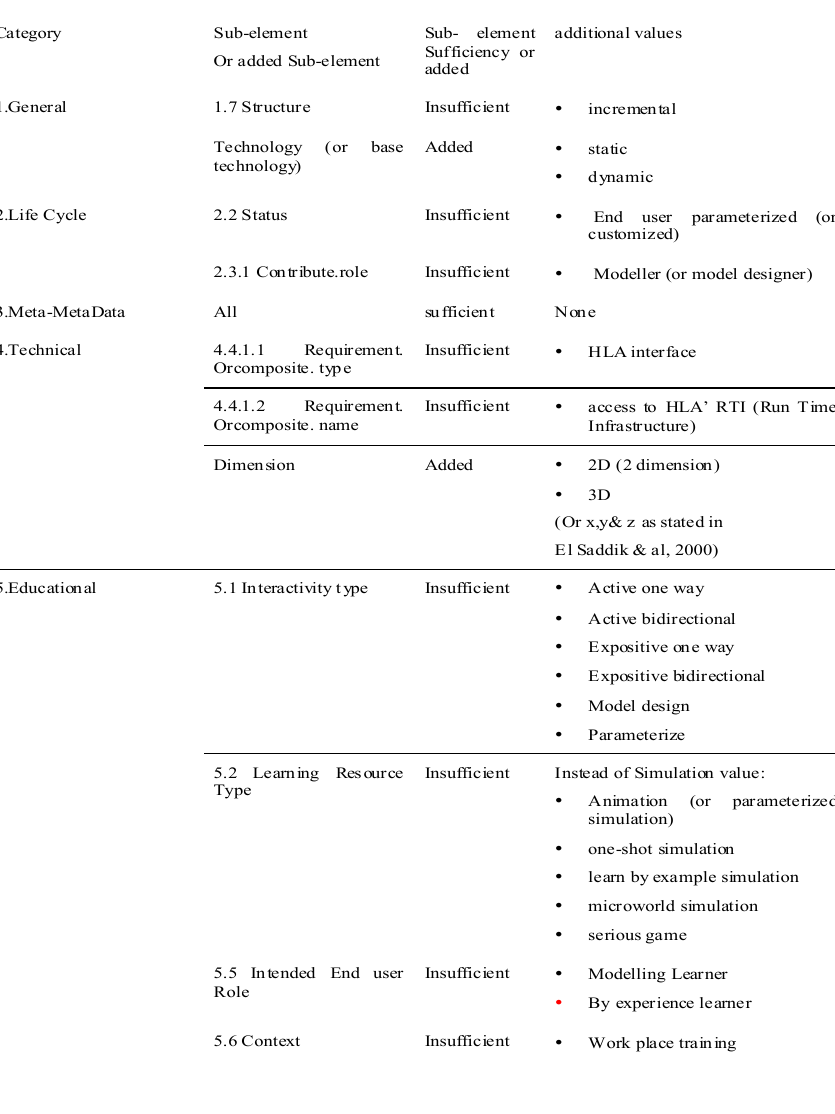
Table 3. Our proposal for lom